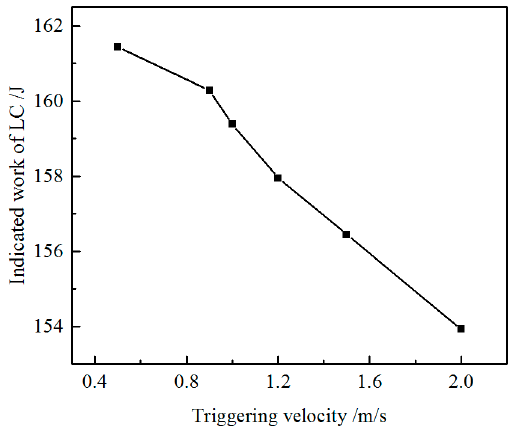
Figure 13. Indicated work variation of the LC for different values of the “triggering velocity” (simulation).